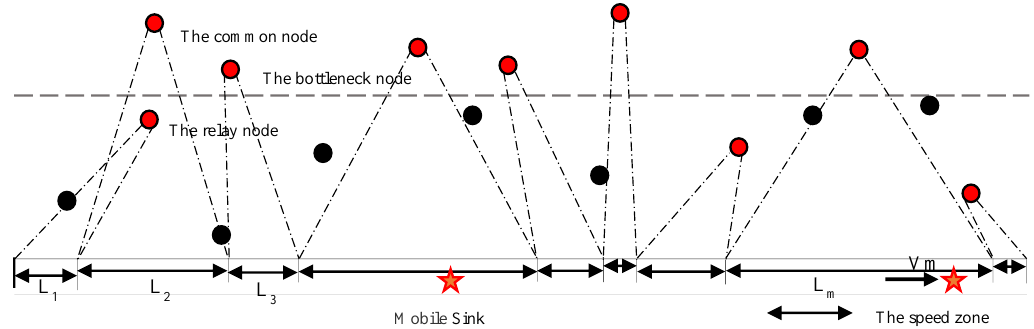
Figure 5. The MS moves on the trajectory according to the area speed.